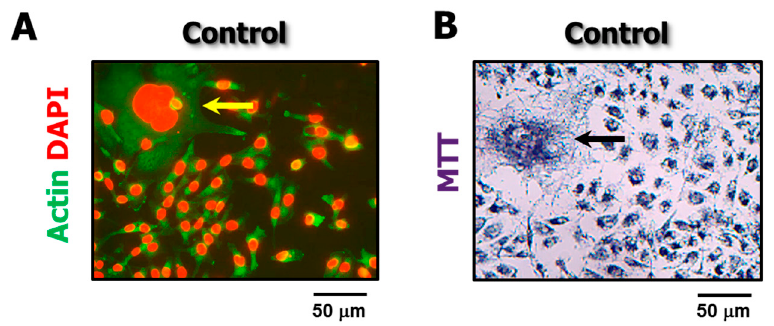
Figure 4. Representative fluorescence ( A ) and bright-field microscopy ( B ) images showing the presence of “enormous” cells (arrows) in proliferating cultures of the MDA-MB-231 cell line in the absence of exogenous stress.